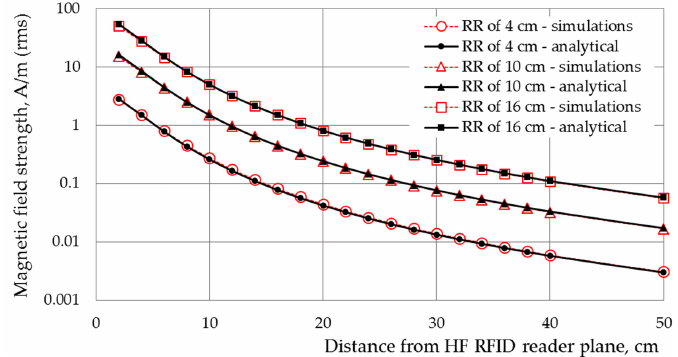
Figure 3. The EMF distribution (magnetic component), evaluated analytically and numerically (by Sim4Life software) and calculated along the axis perpendicular to the HF RFID reader with an antenna with inner dimensions of 8 × 8 cm, assuming that the output power of the reader is sufficient to ensure the RR of the considered reader: 4, 10 or 16 cm, according to ISO/IEC 14443-2:2020 requirements for PICCs of classes 1–3 (i.e., RH = 1.5 A/m).